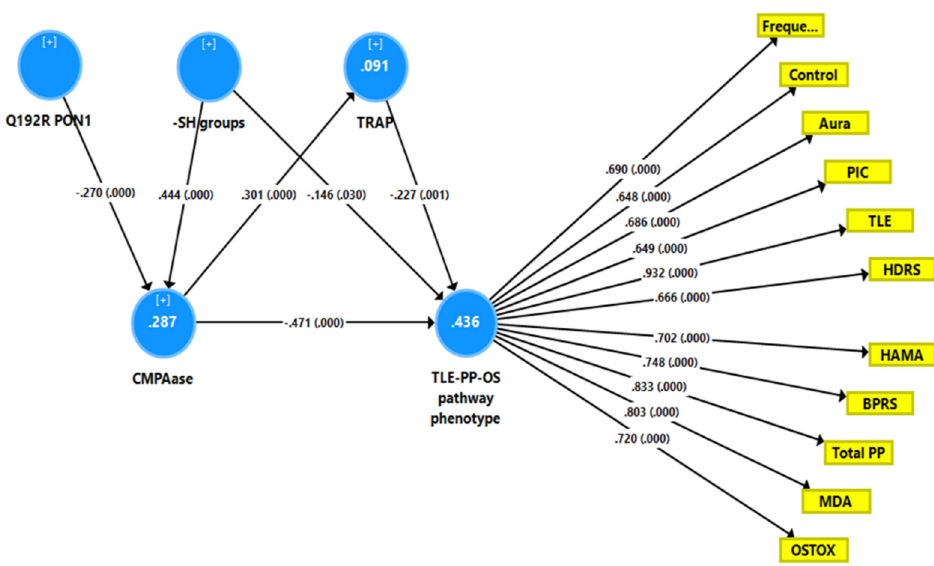
Figure 4. Results of partial least squares (PLS) analysis showing a second causal model with the combined temporal lobe epilepsy (TLE), psychopathology (PP) and oxidative stress (OS) score as output variable (TLE-PP-OS pathway phenotype) and the Q192R variant (additive model), CMPAase 4-(chloromethyl)phenyl acetate ase, -SH groups, and total radical trapping parameter (TRAP) as input variables, whereby TRAP and CMPAase activity mediate the effects of the genotype and -SH groups on the TLE-PP-OS pathway phenotype. OSTOX: index of oxidative toxicity; MDA: malondialdehyde; Freque: frequency of seizures; control: uncontrollability of seizures; aura: history of aura; PIC: post-ictal confusion; HDRS and HAM-A: Hamilton Depression and Anxiety Rating Scales; BPRS: Brief Psychiatric Rating Scale; PP: psychopathology.